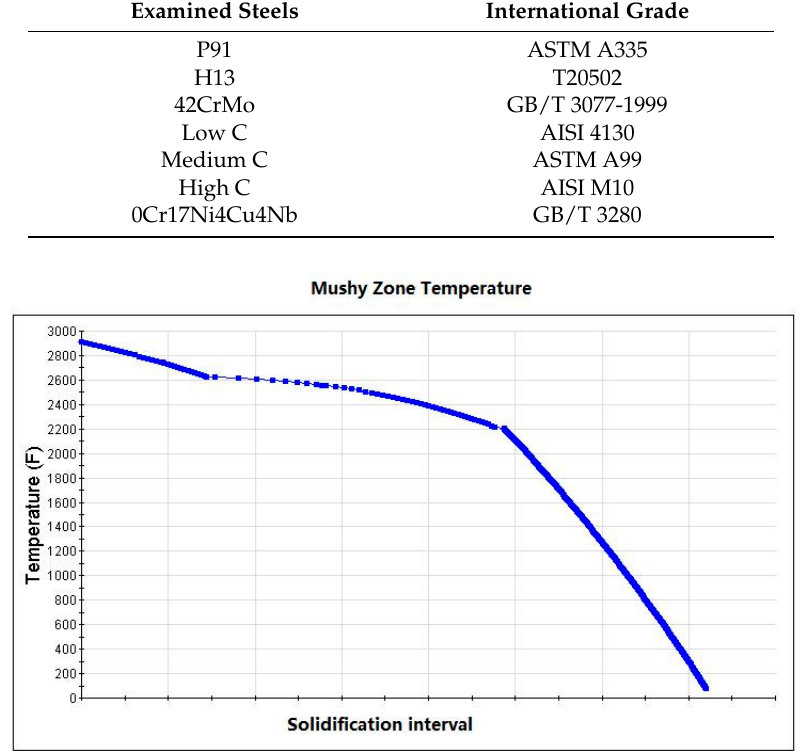
Figure 1. The simulated liquidum and solidum temperatures of 0Crl7Ni4Cu4Nb.